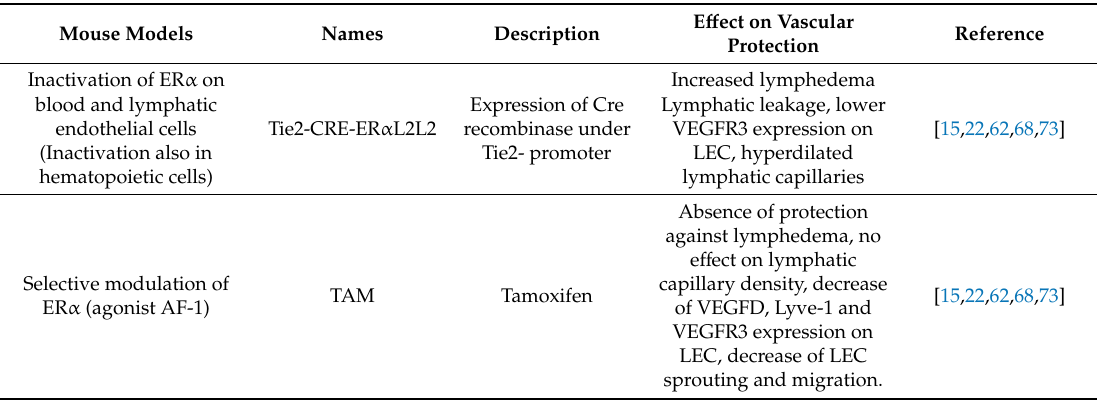
Table 2. Summary of lymphatic e ff ects in mouse models of E2 and pharmacological